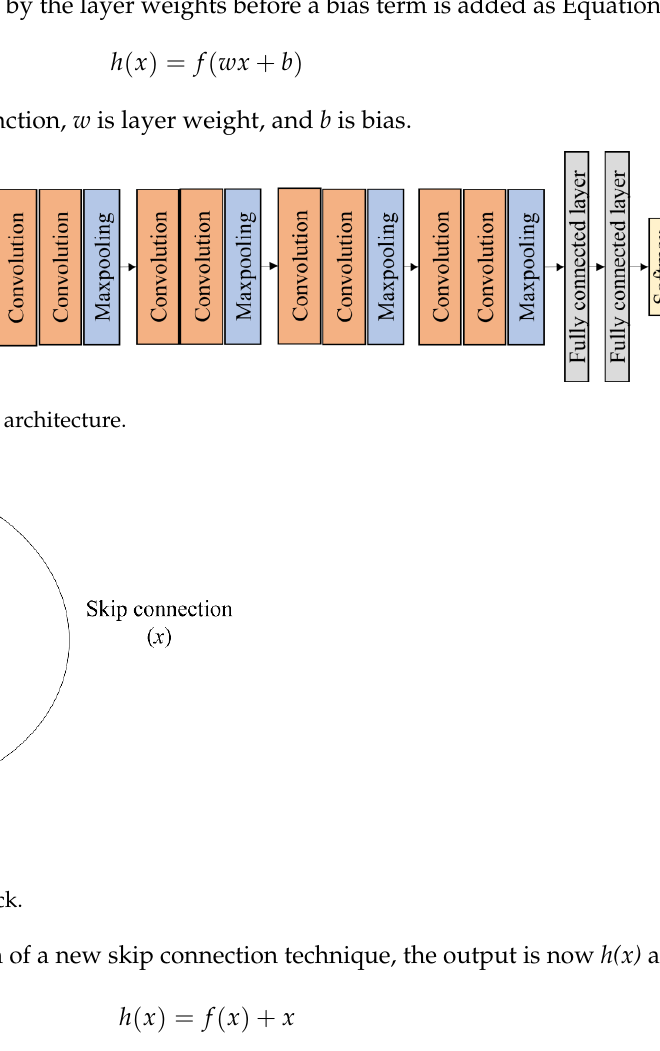
Figure 7. Fine-tuned ResNet50 and ResNet152 architecture (n* = 4 for ResNet50, 8 for ResNet152; n** = 6 for ResNet50, 36 for